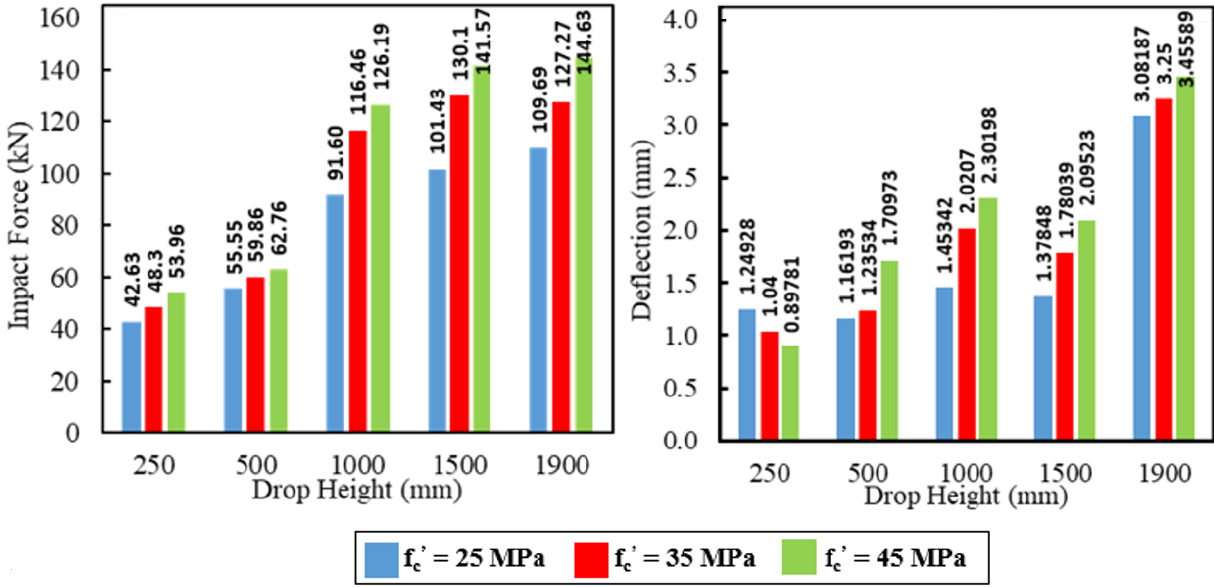
Figure 21. The effect of concrete compressive strength on the impact forces and mid ‐ span deflections for the composite specimen CG ‐ I.